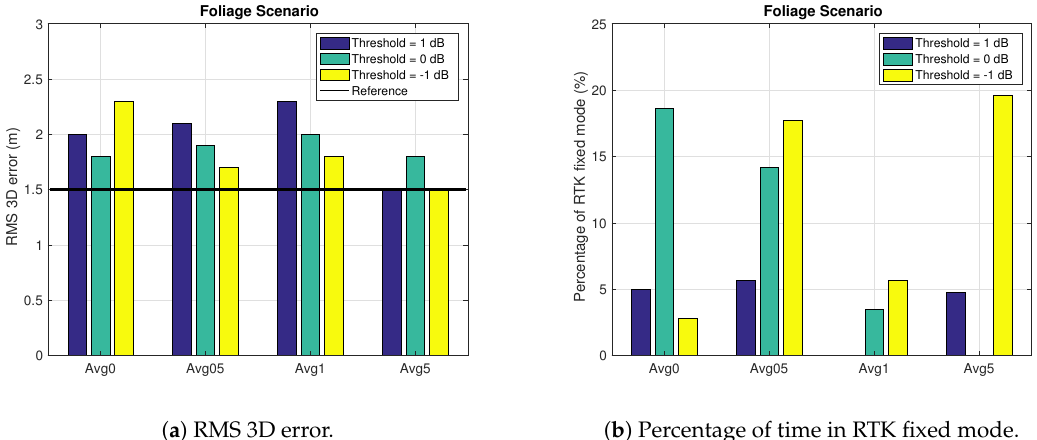
Figure 15. Results in the Foliage scenario for different exclusion thresholds and average configurations. The reference value is omitted in ( b ) due to the large difference with the values illustrated in the